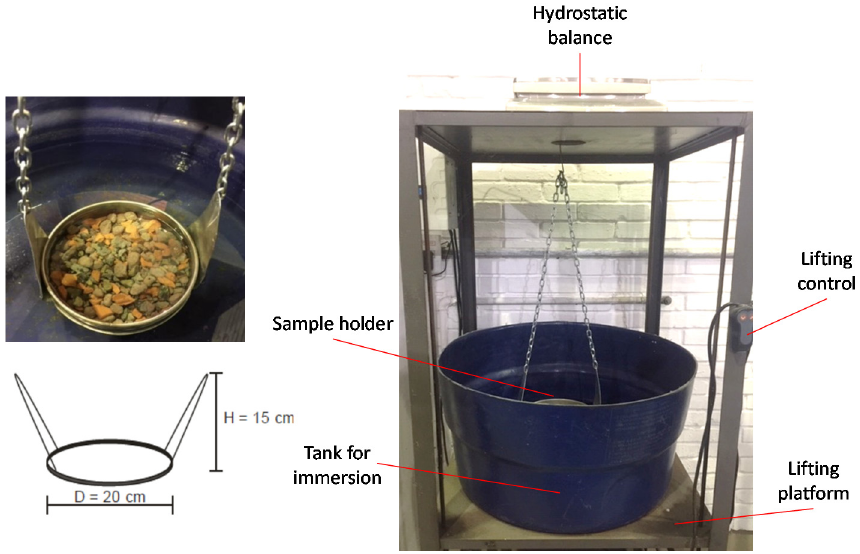
Figure 4. Sample holder ( left ) and experimental apparatus ( right ) used in the water absorption tests.